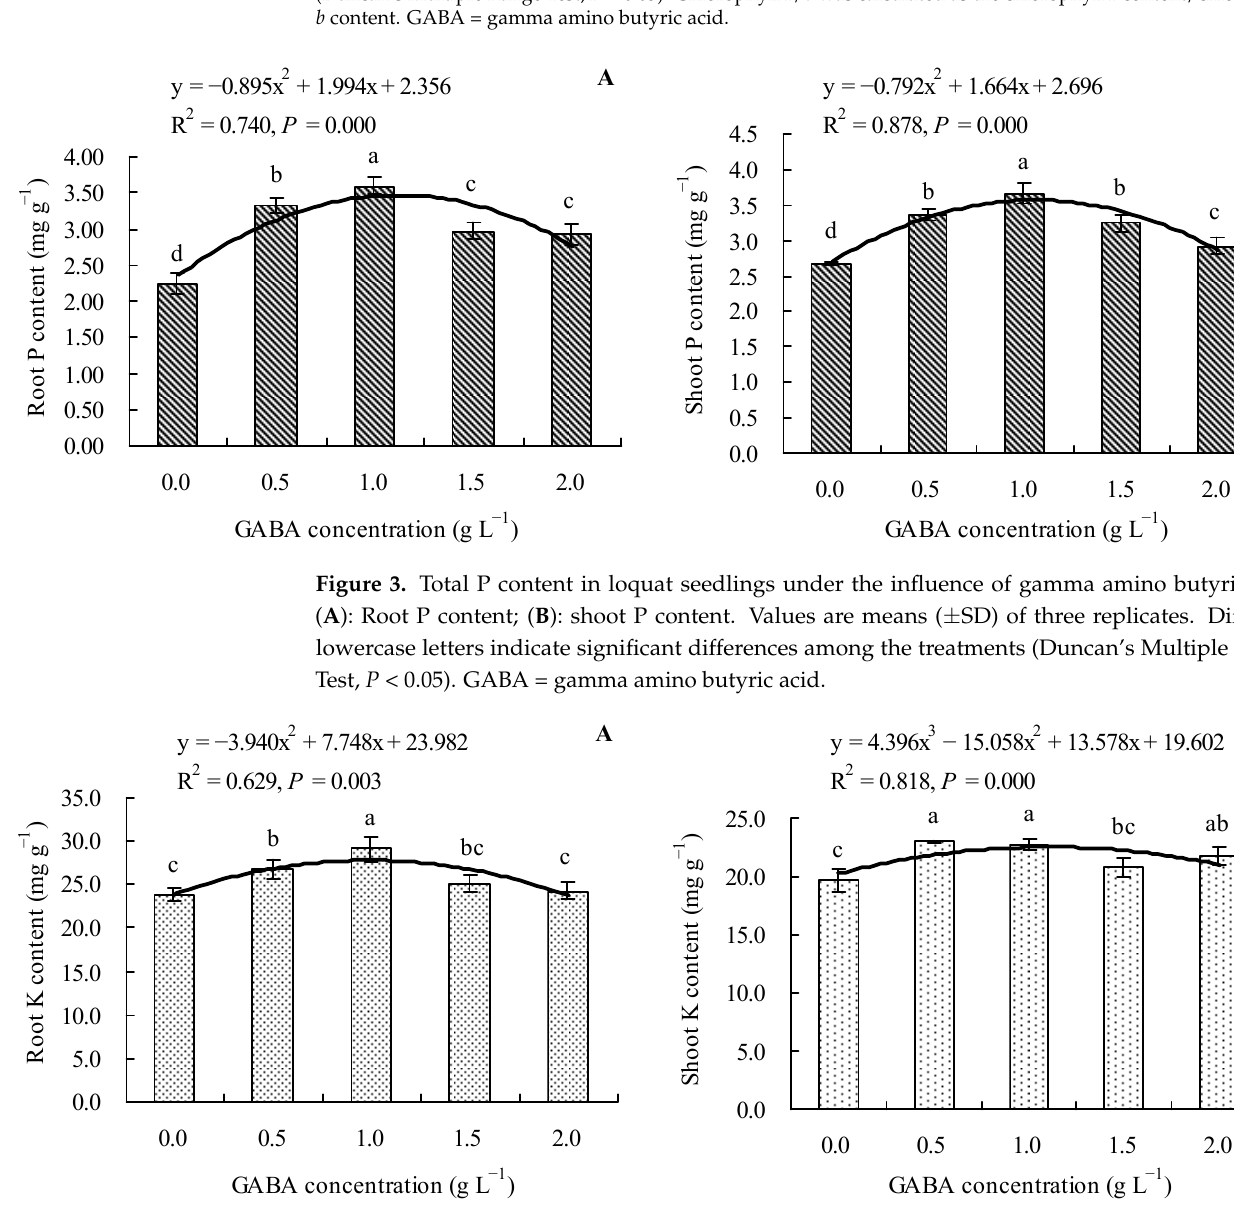
Figure 4. Total K content in loquat seedlings under the influence of gamma amino butyric acid. ( A ): Root K content; ( B ): shoot K content. Values are means ( ± SD) of three replicates. Different lowercase letters indicate significant differences among the treatments (Duncan’s Multiple Range Test, P < 0.05). GABA = gamma amino butyric acid.